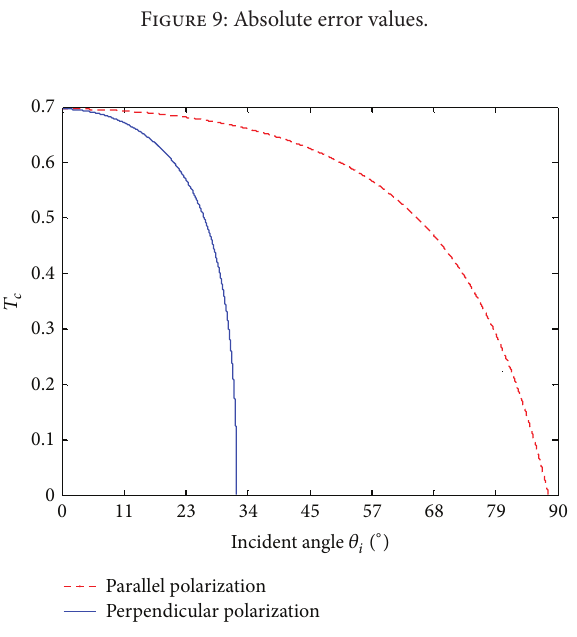
Figure 10: Effects of 𝜃 𝑖 on 𝑇 𝑐 .